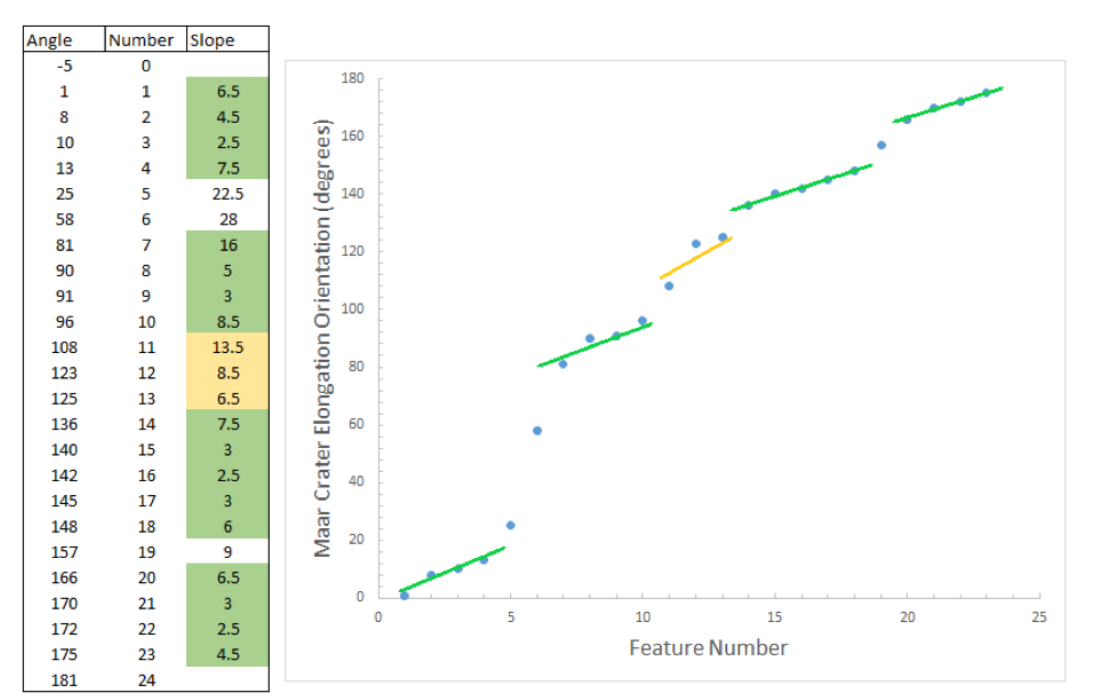
Figure 3: Graph of primary elongation orientations for maars in the Pali Aike Volcanic Field and line used to classify modes of shared orientations. Areas in which the slope is less than five are highlighted green, making up the strong modes. Areas of the line highlighted yellow have a slope less than ten and make up weak